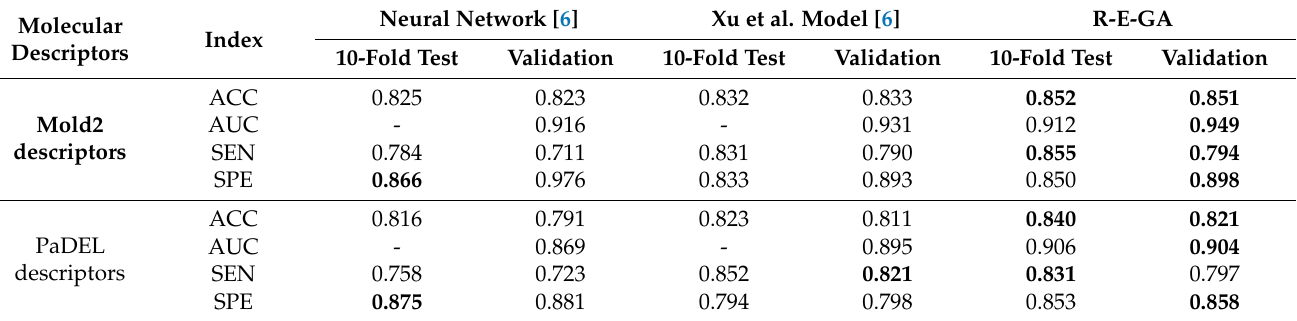
Table 4. Performance of training using Mold2 and PaDEL descriptors in external validation study.